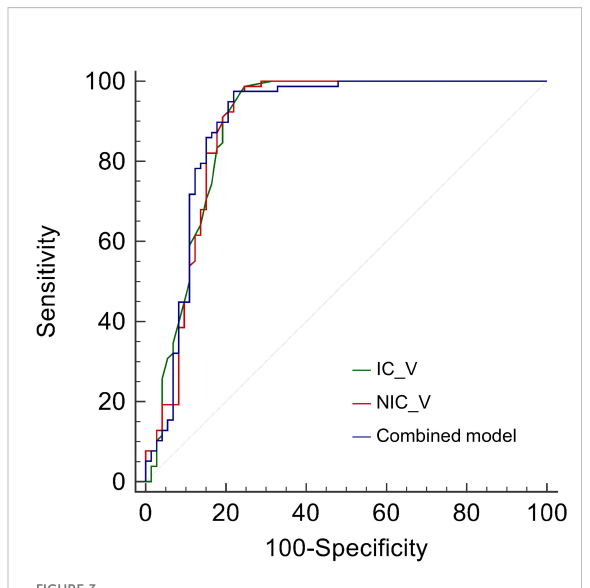
FIGURE 3 Receiver operating characteristic curves of iodine concentration in venous phase (IC_V), normalized iodine concentration in venous phase (NIC_V), and combined model for differentiating lung cancers from benign solid pulmonary